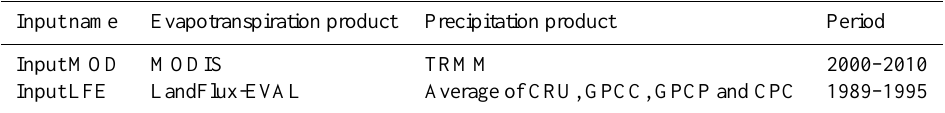
Table 1. Input data sets used for building moisture recycling networks. The first year of the period is omitted from the results because of model